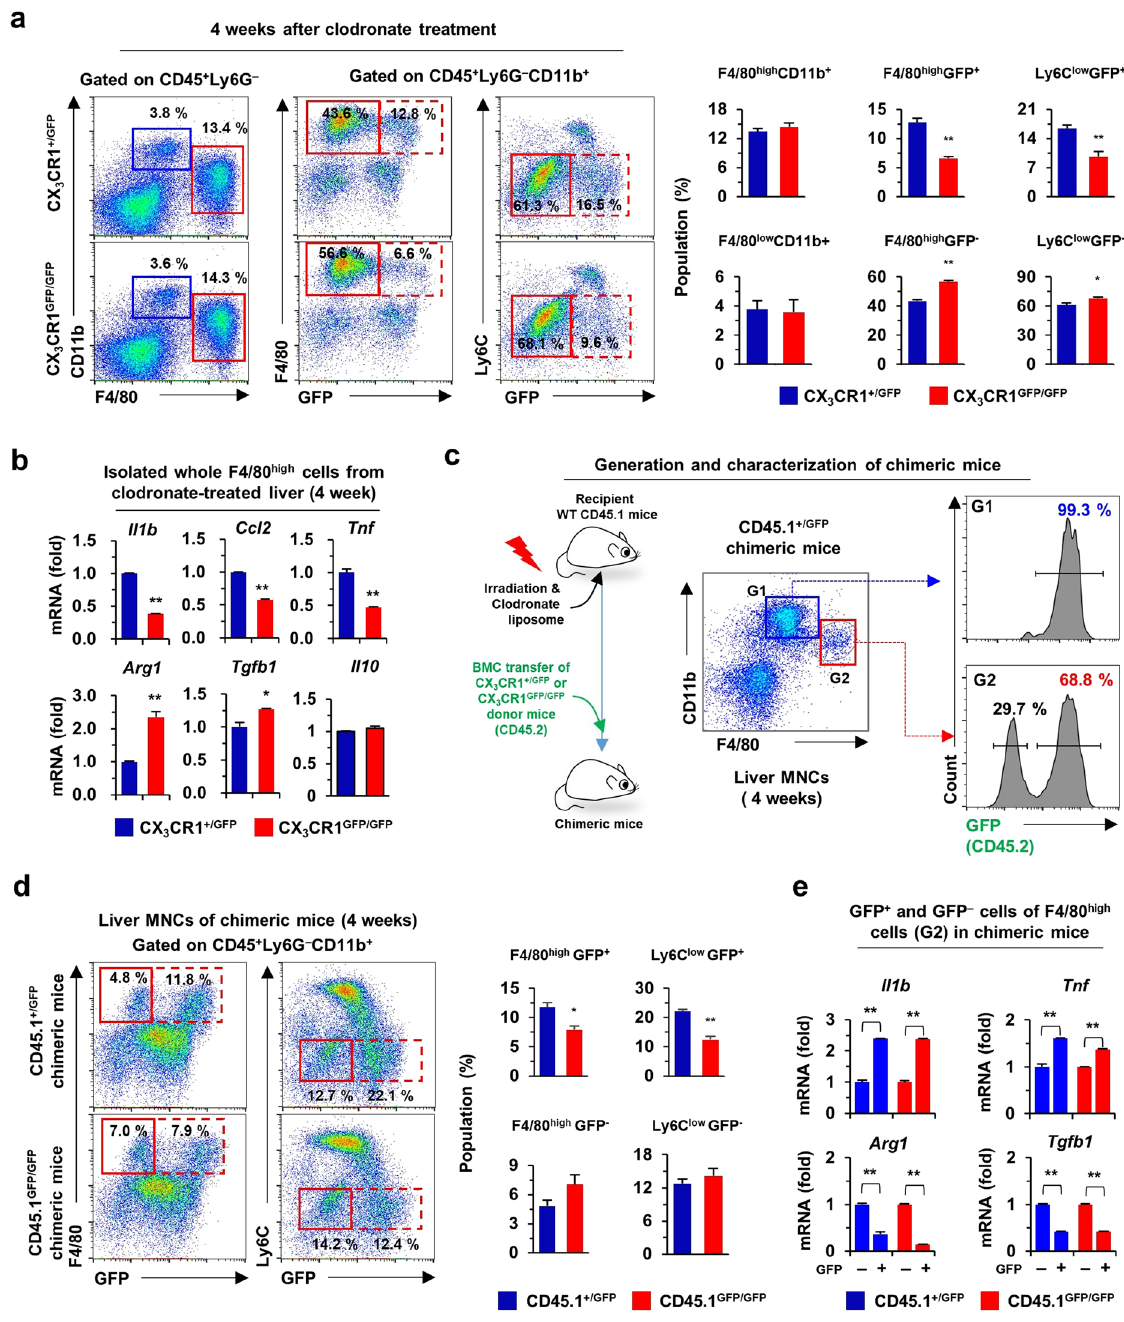
Figure 5. CX 3 CR1 expression assigns two subsets and pro-inflammatory phenotype to F4/80 high or Ly6C low macrophages in the liver. ( a ) Liver monocytes and macrophages were analyzed by flow cytometry using isolated liver MNCs of CX 3 CR1 + /GFP and CX 3 CR1 GFP/GFP mice and 4-week after clodronate liposome treatment. ( b ) Isolated whole F4/80 high cells were subjected to qRT-PCR analysis at week 4 after clodronate liposome treatment. ( c ) To generate chimeric mice, recipient wild type mice (CD45.1) were transplanted with donor bone marrow cells (BMC) of CX 3 CR1 + /GFP or CX 3 CR1 GFP/GFP mice (CD45.2) after irradiation and clodronate liposome treatment. Chimerism was assessed by expression of GFP (CD45.2) in liver MNCs of recipient mice. ( d ) Isolated liver MNCs from chimeric mice were subjected to flow cytometry. ( e ) F4/80 high GFP + and F4/80 high GFP − cells of chimeric mice were subjected to qRT-PCR analysis. Data are expressed as the mean ± SEM. * p < 0.05, ** p < 0.01 compared to GFP − F4/80 high cells. The results represent two independent